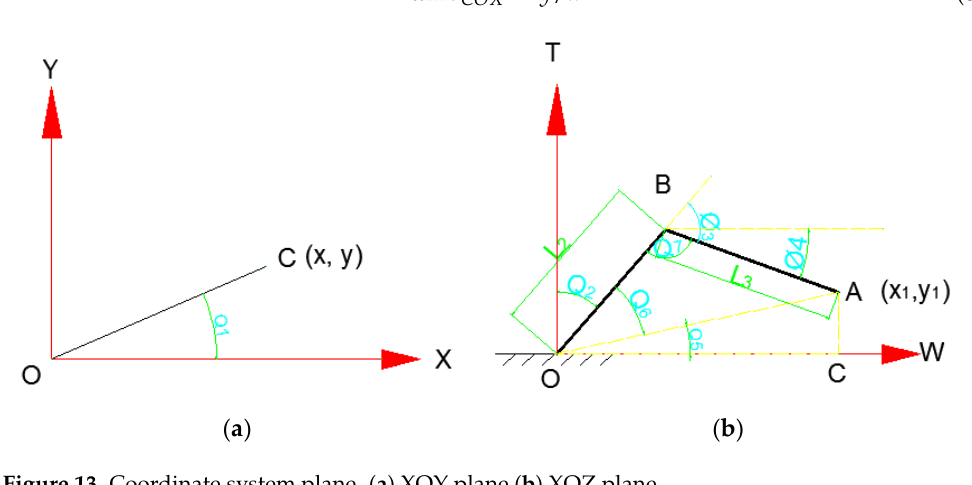
Figure 14. Inverse kinematics solution flow of mechanical arm geometry method. After the teaching is completed, the program loads the finalized XML action param- eter file. The program reads the corresponding direction and step parameters of the X , Y and Z motors in sequence, executes them in sequence, and controls the high- and low- level outputs of the related pins of the Raspberry Pi to control the operation of the motor. Among them, the rotation angle of the robot arm corresponding to the step parameter 1024 is 18°, and the maximum is 10,240.